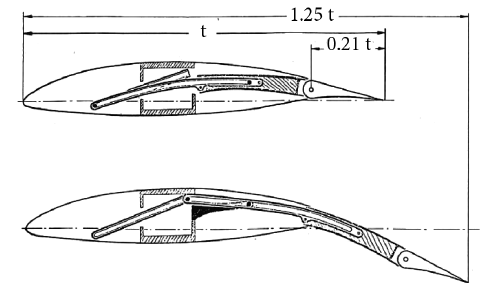
Fig. 3. SB-11 using Wortmann flaps (Horstmann, Quast 1979)